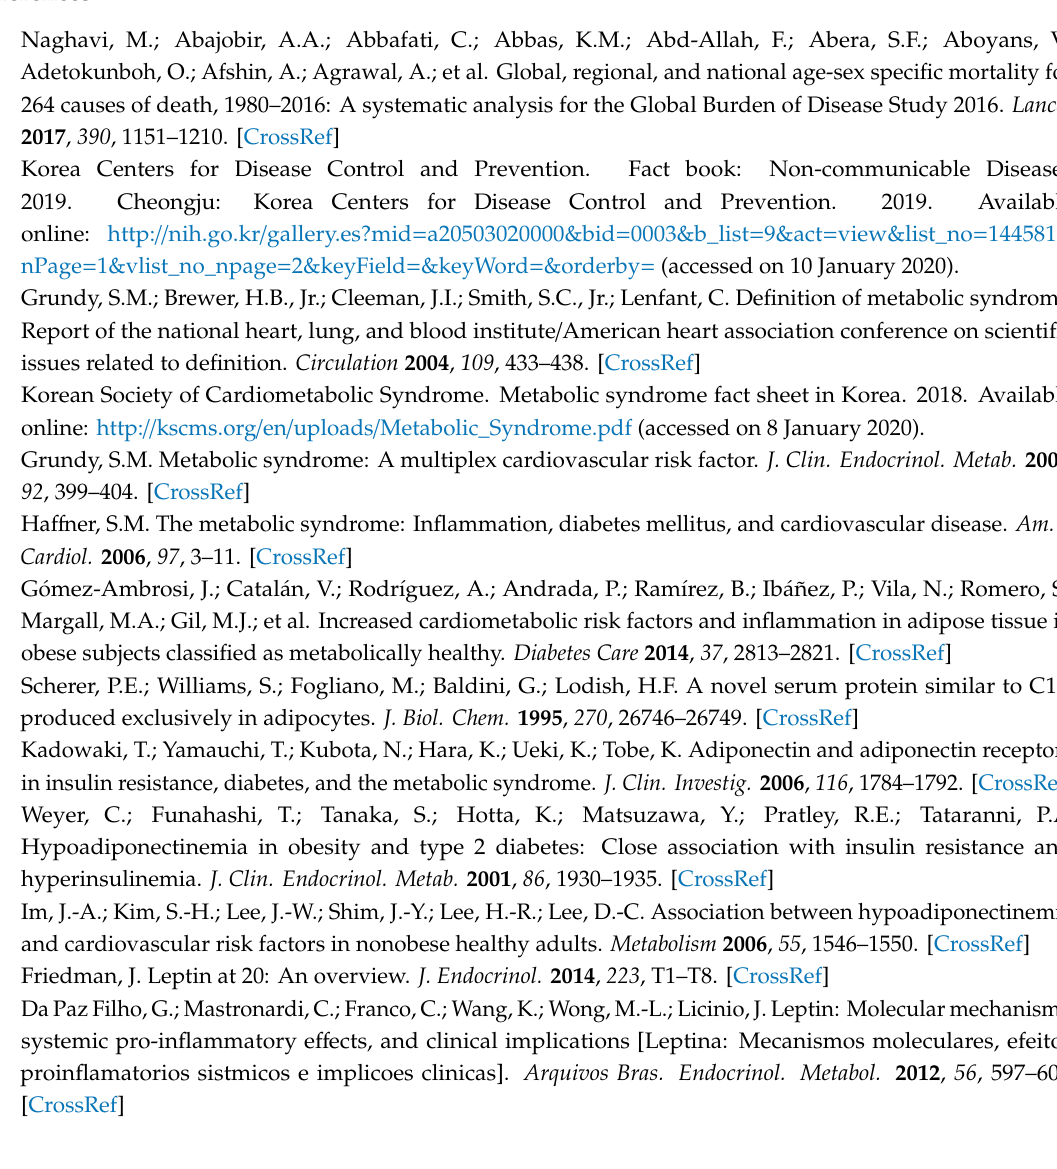
Table S1: Characteristics of the study participants according to adiponectin levels in Korean men and women aged 45–76 years; Table S2: Characteristics of the study participants according to leptin levels in Korean men and women aged 45–76 years; Table S3: Adjusted hazard ratios (with 95% confidence intervals) for each component of metabolic syndrome according to baseline serum adiponectin, leptin levels, and leptin-adiponectin ratio in Korean men aged 45–76 years; Table S4: Adjusted hazard ratios (with 95% confidence intervals) for each component of metabolic syndrome according to baseline serum adiponectin, leptin levels, and leptin-adiponectin ratio in Korean women aged 45–76